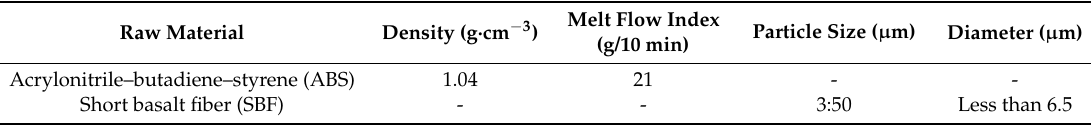
Figure 1. Composite raw material. ( A ) acrylonitrile–butadiene–styrene (ABS); ( B ) Short basalt fiber (SBF). Table 1. Specification of the raw material of the composite.